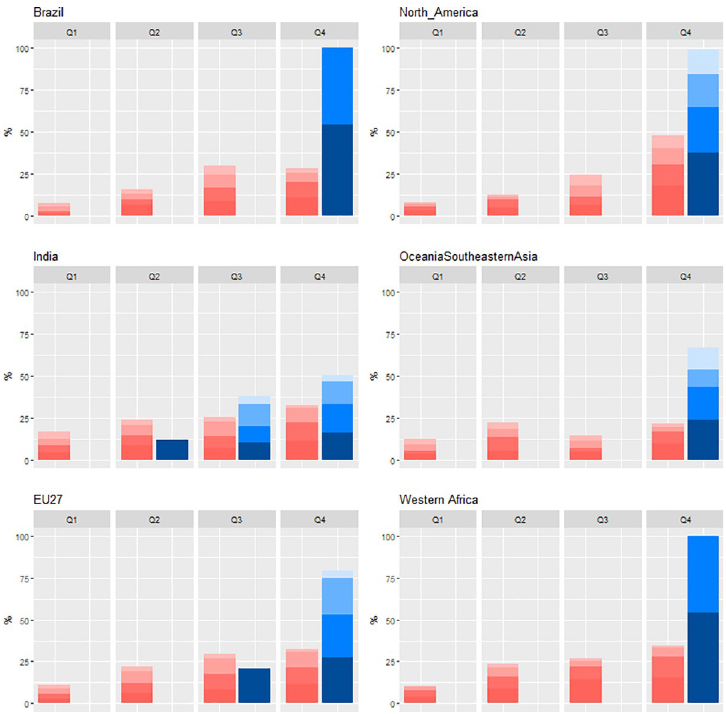
Fig 4. Percentages of cropland area allocated to four different classes (Q1, Q2, Q3, Q4) of suitability (red) and theoretically possible distribution (blue) for six regions. Shade levels indicate land classes of accessibility, the darkest colors showing the most accessible land. The four land suitability classes were defined from the 1 st quartile, median, and 3 rd quartile of the considered suitability index.